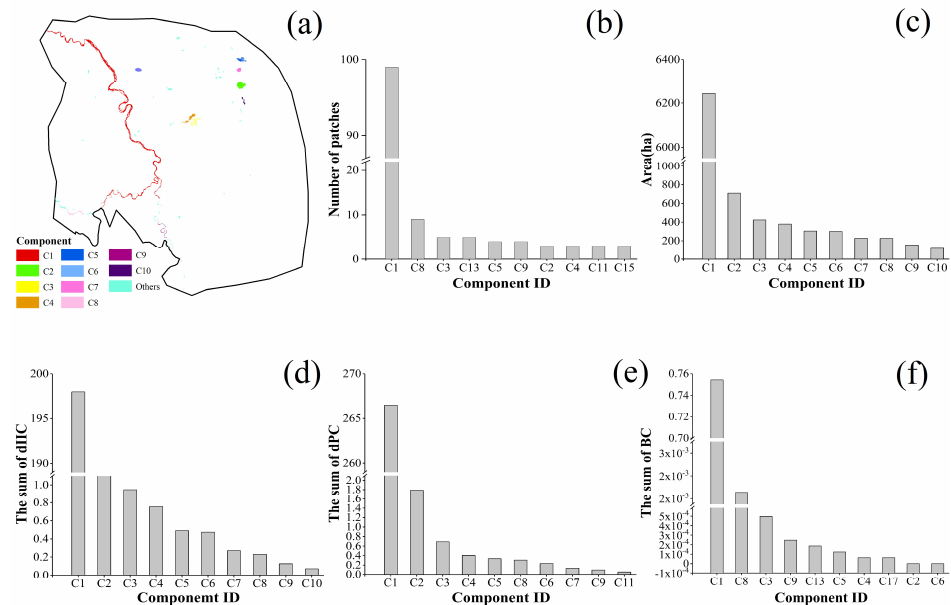
Figure 7. Statistics of different indices for the top 10 components in terms of connectivity for 2019. ( a ) Distribution of components, ( b ) Number of patches per component (n), ( c ) Cumulative area of patches per component (ha), ( d ) The sum of dIIC, ( e ) The sum of dPC, and ( f ) The sum of BC. C1 = Yellow River floodplain, C2 = Haqiucuogan, C3 = Yellow River–Black River corridor (south), C4 = Yellow River–Black River (north), C5 = Cuonidajian, C6 = Xingcuo, C7 = Cuorewajian, C8 = Yellow River floodplain @ Cairimaxiang, C9 = White River floodplain, C10 = Cuodawa. Important